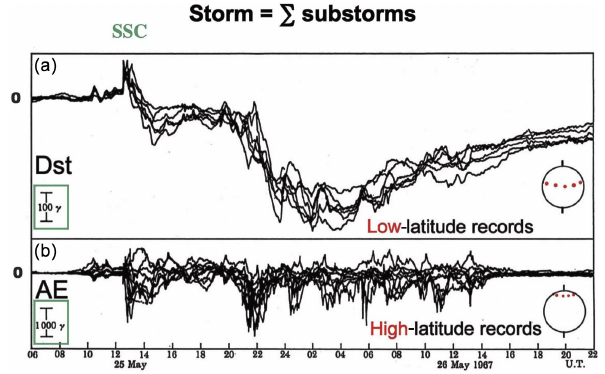
Figure 10. An example of geomagnetic storms. In the upper part, magnetic records (the H component) from low-latitude stations are assembled; the Dst index is the average of the records. In the lower part, magnetic records (the H component) from high latitudes are assembled; the range between the upper and lower envelopes pro- vides the AE